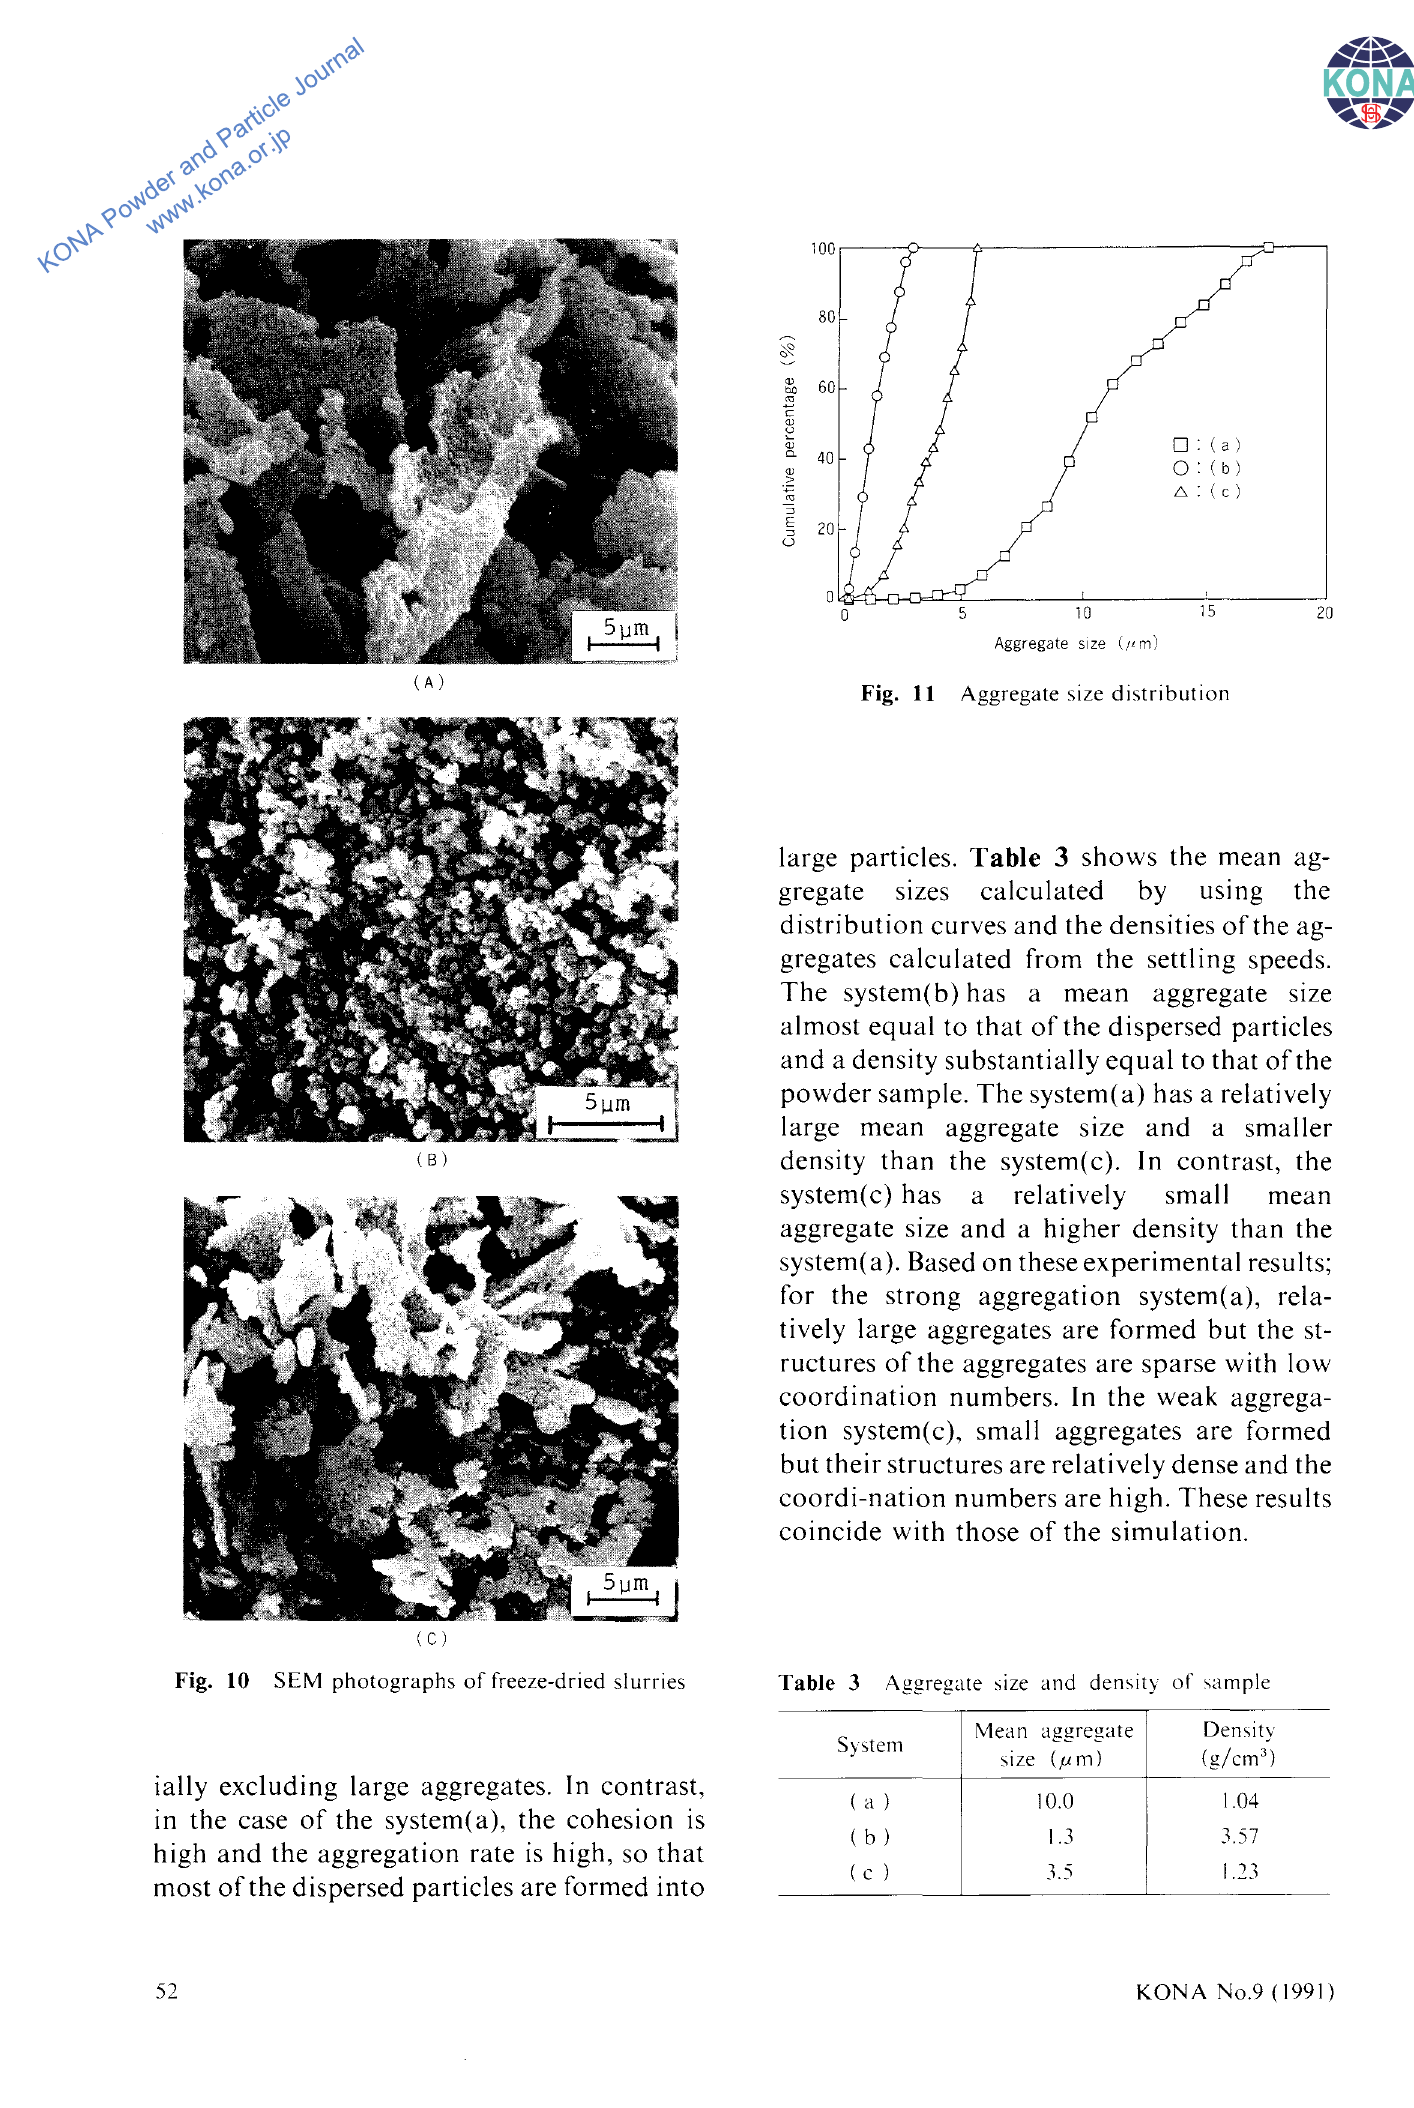
Fig. 10 SEM photographs of freeze-dried slurries ially excluding large aggregates. In contrast, in the case of the system(a), the cohesion is high and the aggregation rate is high, so that most of the dispersed particles are formed into